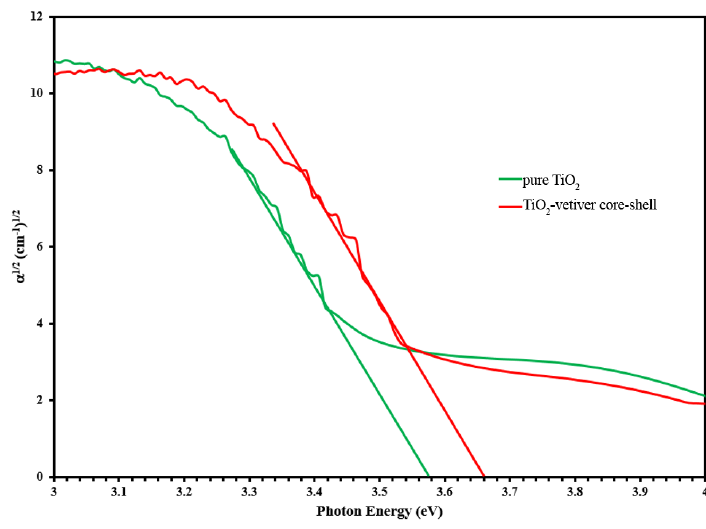
Figure 2. Optical indirect band gaps calculated from DRS data for pure TiO 2 and TiO 2 -vetiver core–shell.